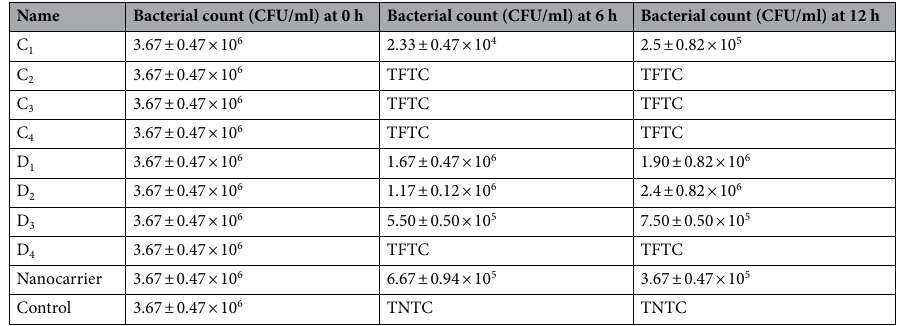
Table 2. Effect of nanocarrier drug compare to free drug on bacterial susceptibility (mean count ± SD) in broth dilution method. TNTC too numerous to count, TFTC too few to count, C 1 , C 2 , C 3 , C 4 nano carrier with 1, 5, 10, and 20 µg/ml CFX respectively, D 1 , D 2 , D 3 , D 4 1, 5, 10, and 20 µg/ml CFX, respectively.